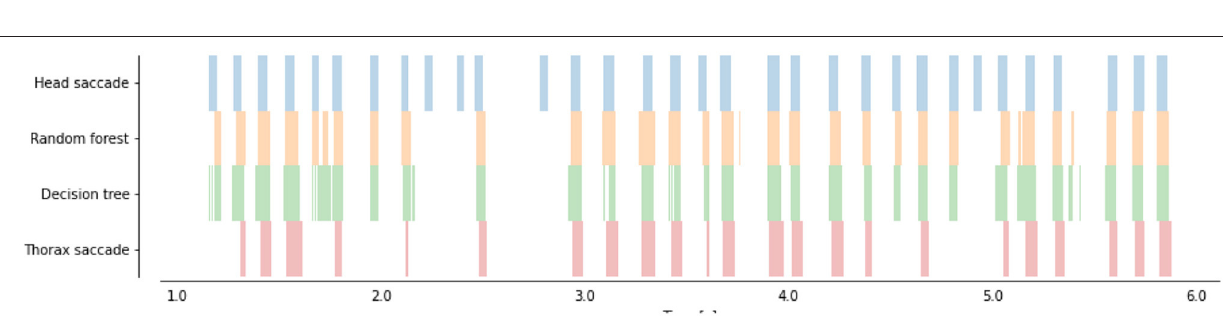
FIGURE 3 | Time course of yaw angles and ω z ( t ) of the head and thorax of a learning flight. Head saccades (blue regions) are extracted with manually chosen thresholds (red dotted line). Body saccades (red regions) are extracted with thresholds to best match the head saccades.